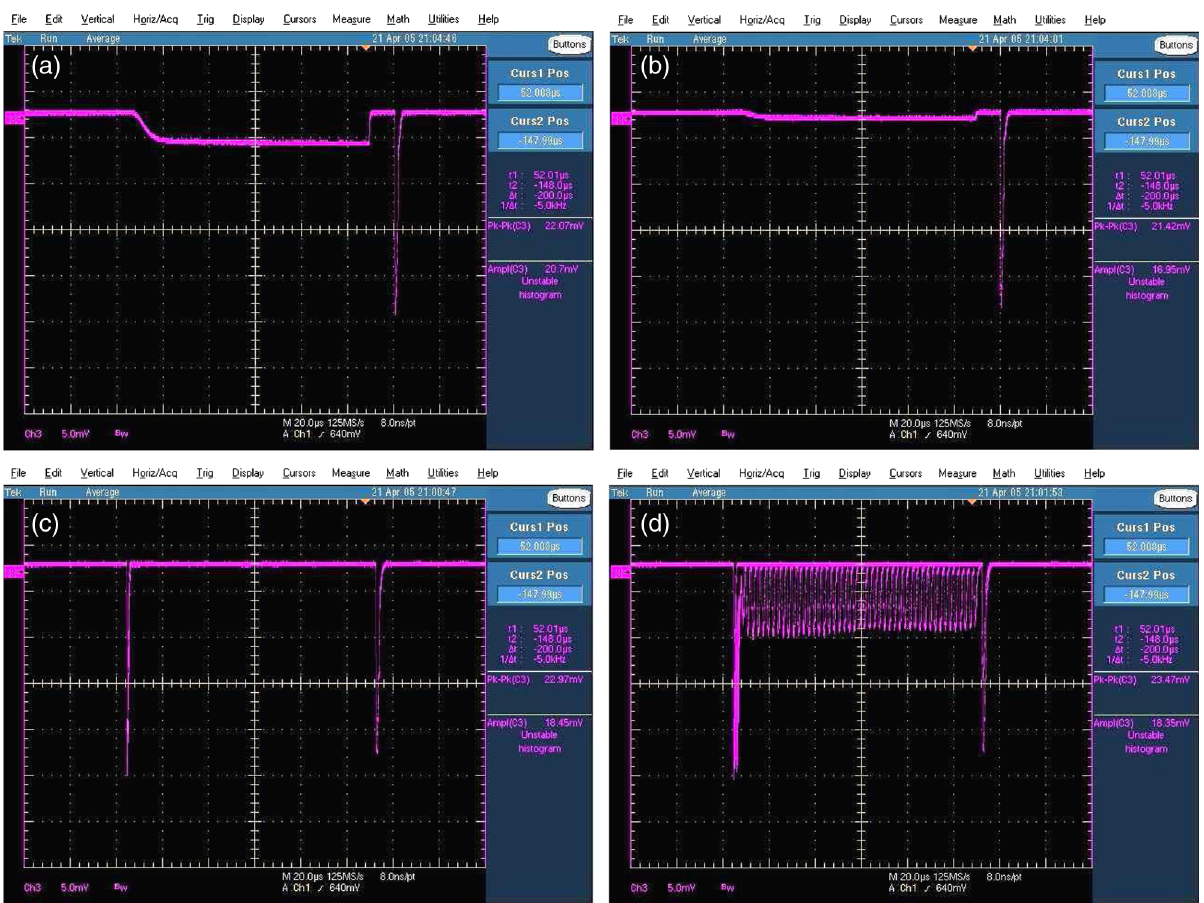
FIG. 7. (Color) Dark current as a function of time measured with the Faraday cup and an oscilloscope for gradients of (a) 40 MV = m , (b) 33 MV = m , (c) 2 : 7 MV = m , and (d) 2 : 4 MV = m on the cathode. The horizontal and vertical scales are 20 (cid:1) s per division and 5 mV per division, respectively. Cathode No. 43.2 was used for this measurement when it was fresh (April 2005). The solenoid currents were 400 A in the main solenoid and 30 A in the bucking solenoid. At the lowest gradient, multipacting takes place over the entire rf pulse and appears as an oscillation